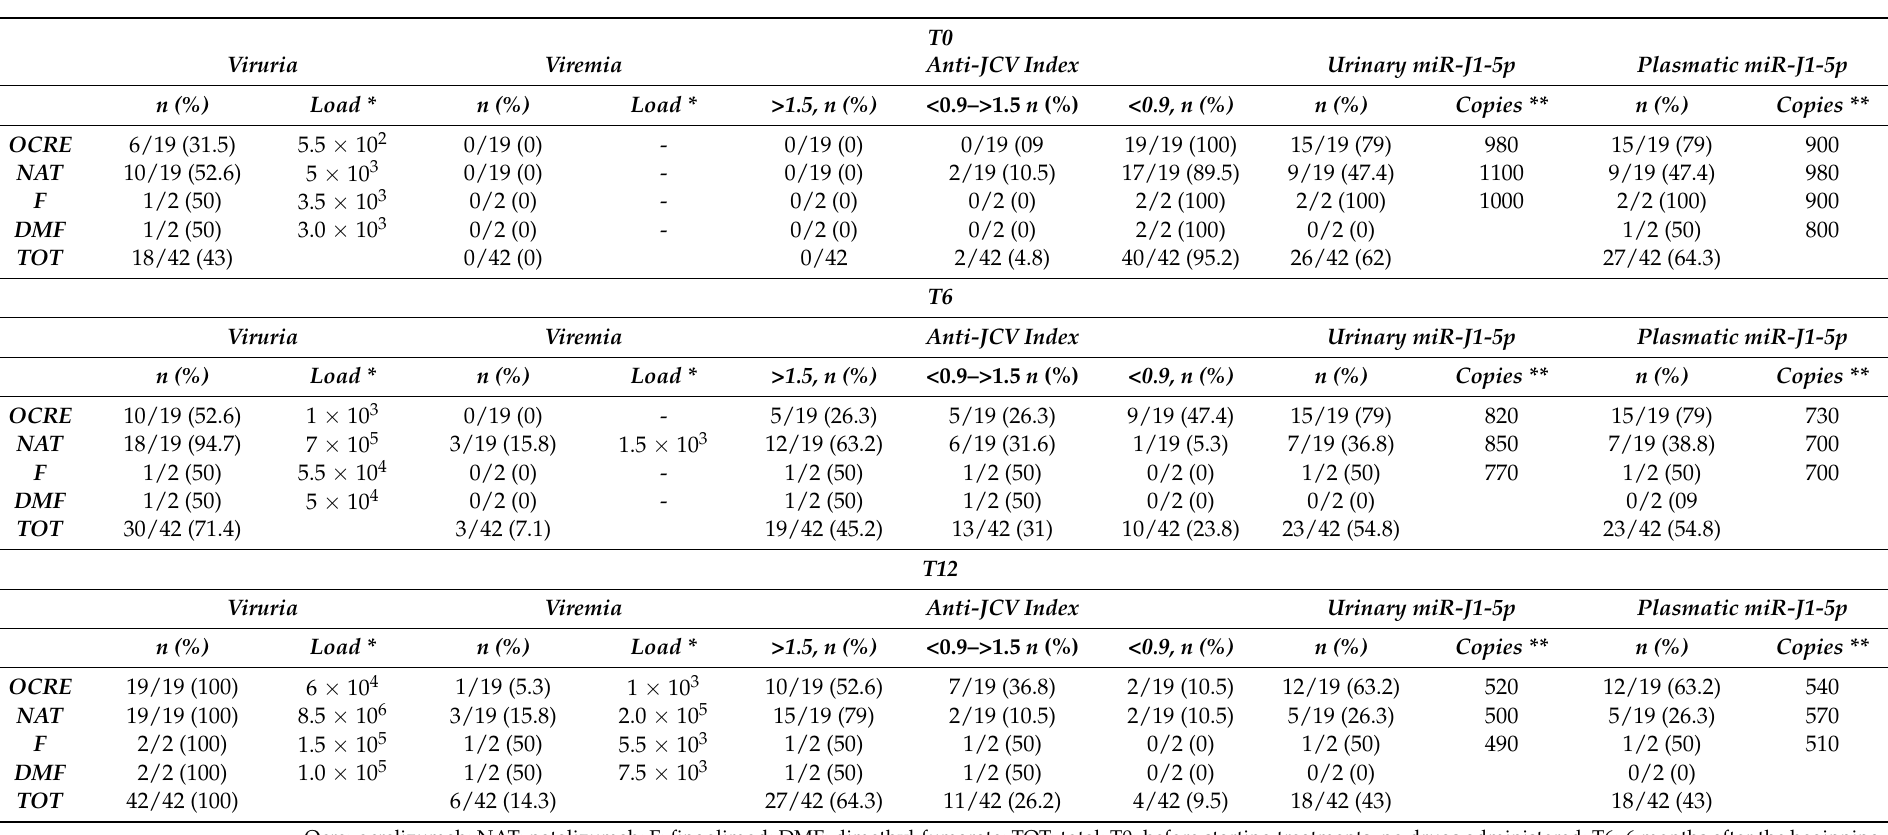
Table 1. JCPyV viruria, viremia, anti-JCV index and miRNAs expression: longitudinal investigation in multiple sclerosis patients